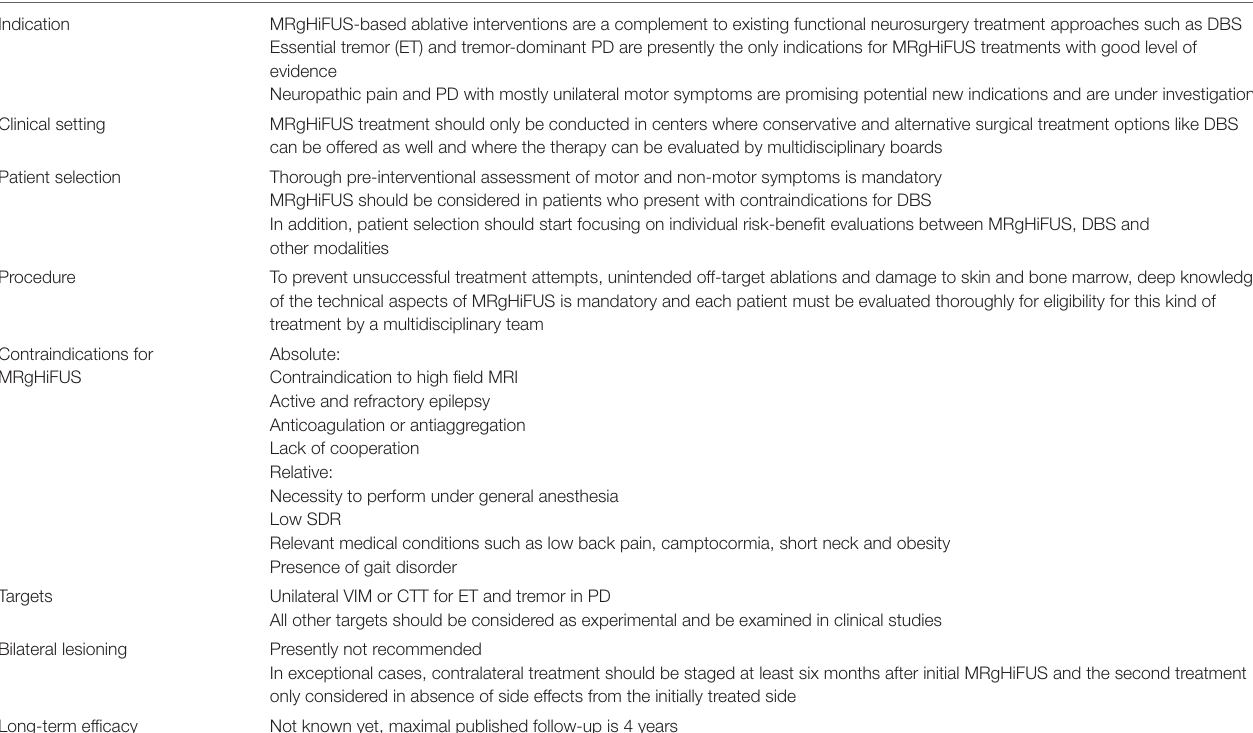
TABLE 1 | Summary of the core recommendation for the use of MRgHiFUS. Indication